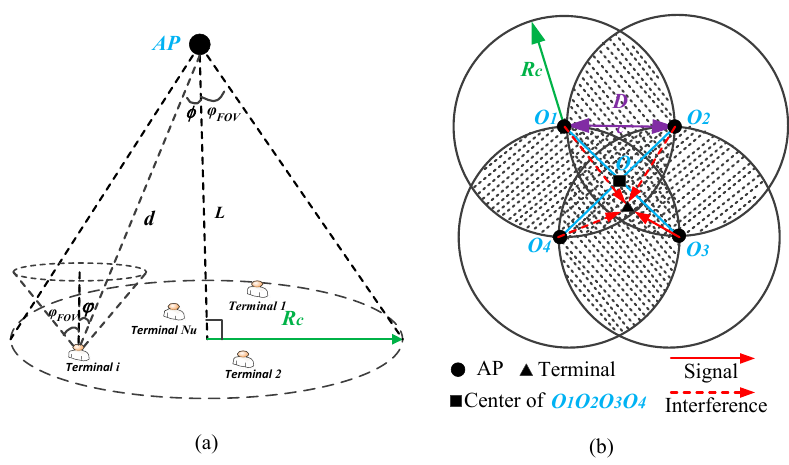
Figure 1. The visible light communication ultra-dense networks model: ( a ) the coverage of a single AP and ( b ) the overlapping areas of a local network.